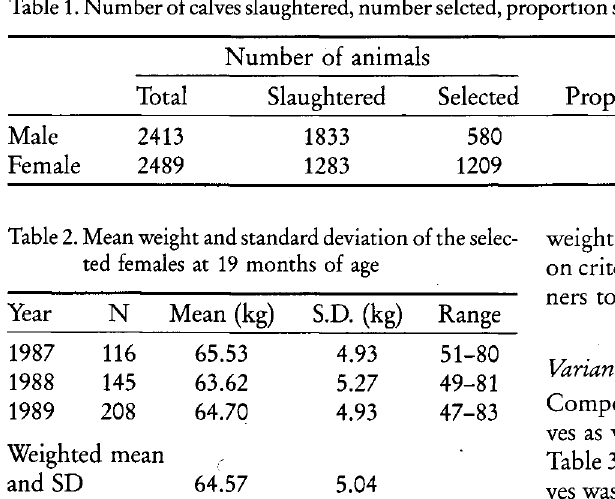
ves as well as the repeatability figures are given in Table 3. For body weight the variance between cal ves was consistently greater than the variation wit hin calves.